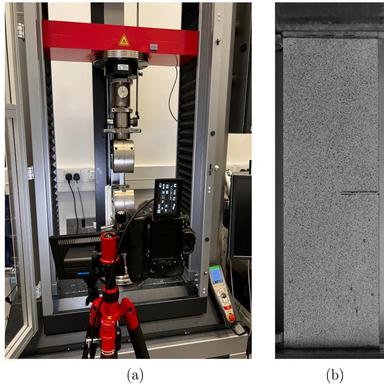
(a) Experimental test set-up including DIC camera and light source; (b) monochromatic image capture of a SENT specimen with a sprayed speckle pattern.